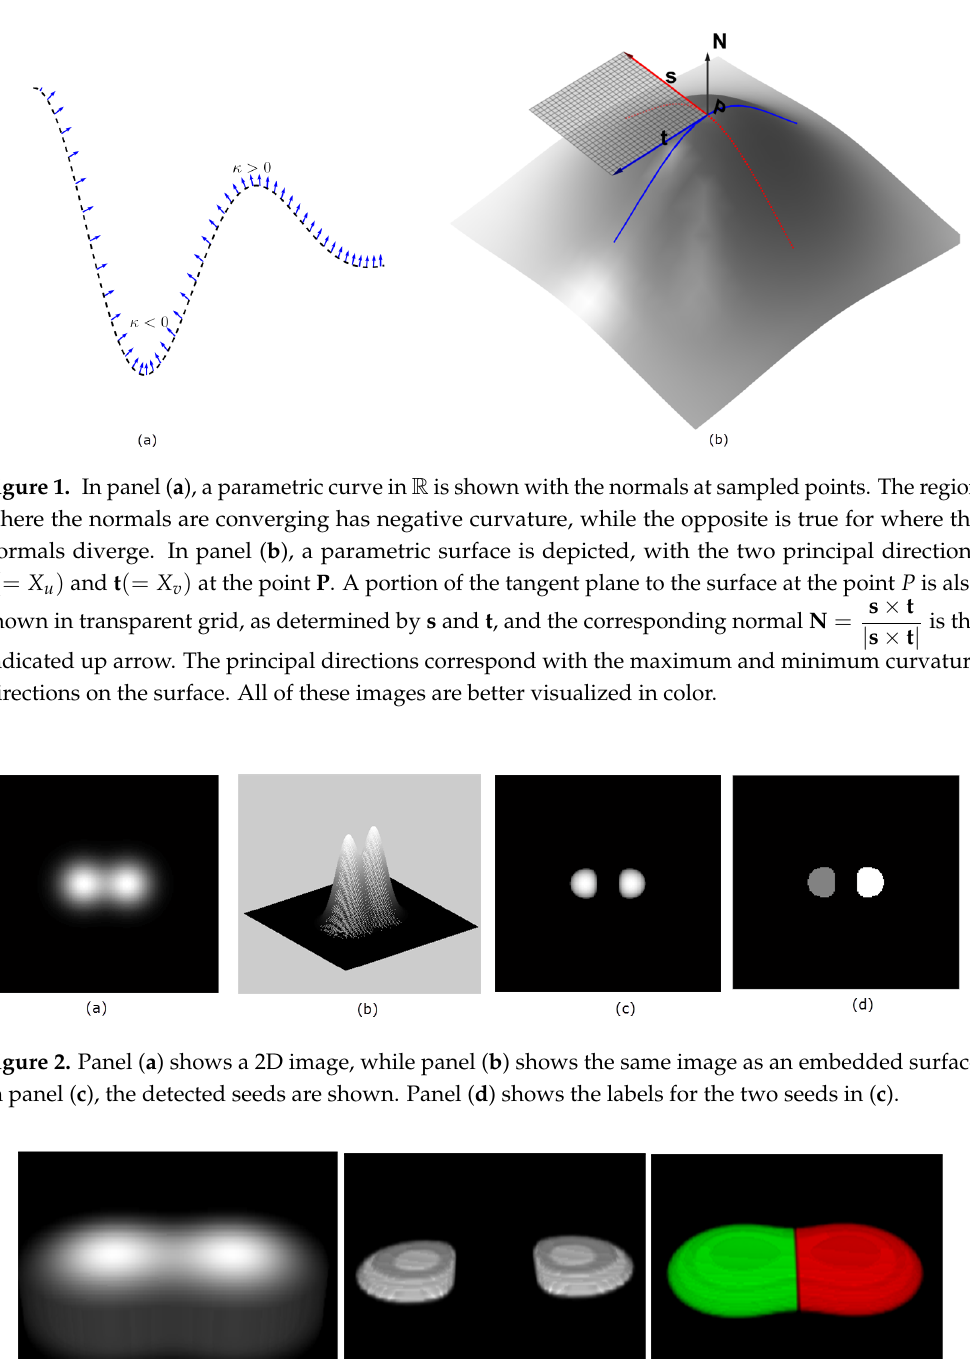
Figure 3. 3D rendering of two objects in ( a ). The located seeds, Ct = k + panel ( b ). The final segmentation is shown in panel ( c